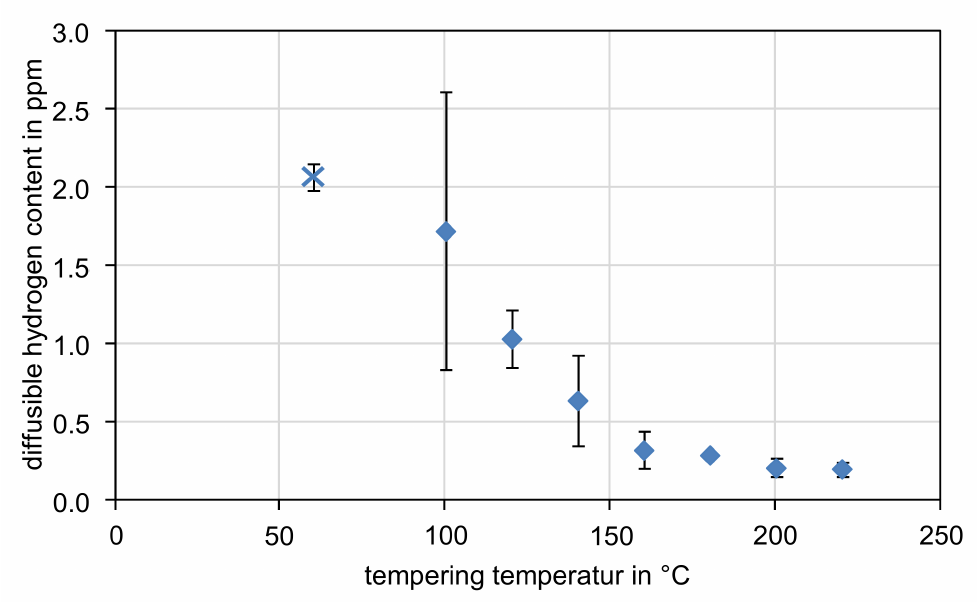
Figure 7. Development of diffusible hydrogen content (HCA method) as a function of tempering temperature (x ± s, n = 3, n (T = 100 ◦ C) = 2).